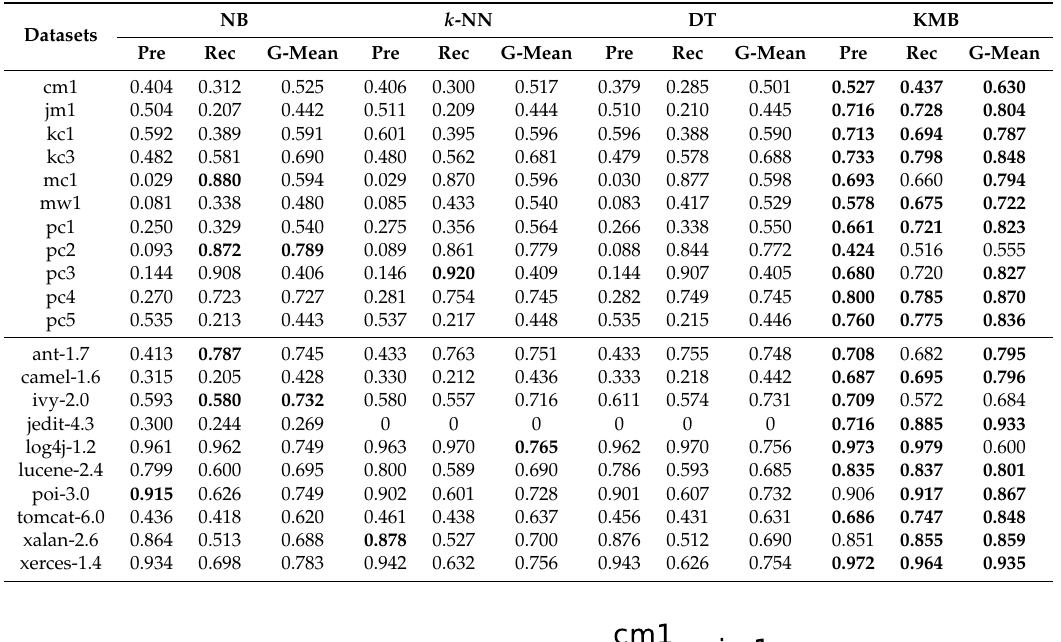
Table 5. Precision, Recall, and G-mean for the basic classifiers and KMB.